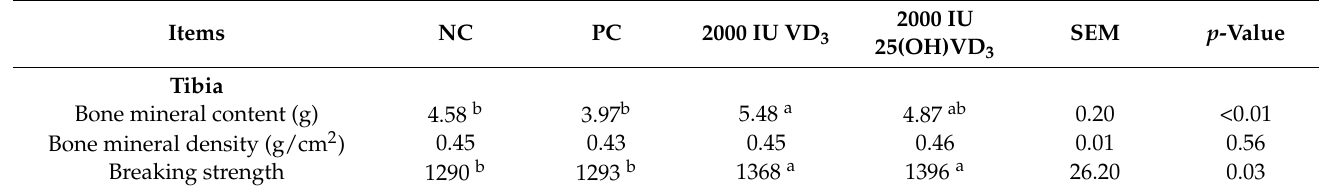
Table 3. Effect of VD 3 and 25(OH)VD 3 on the skeletal performance of weaned